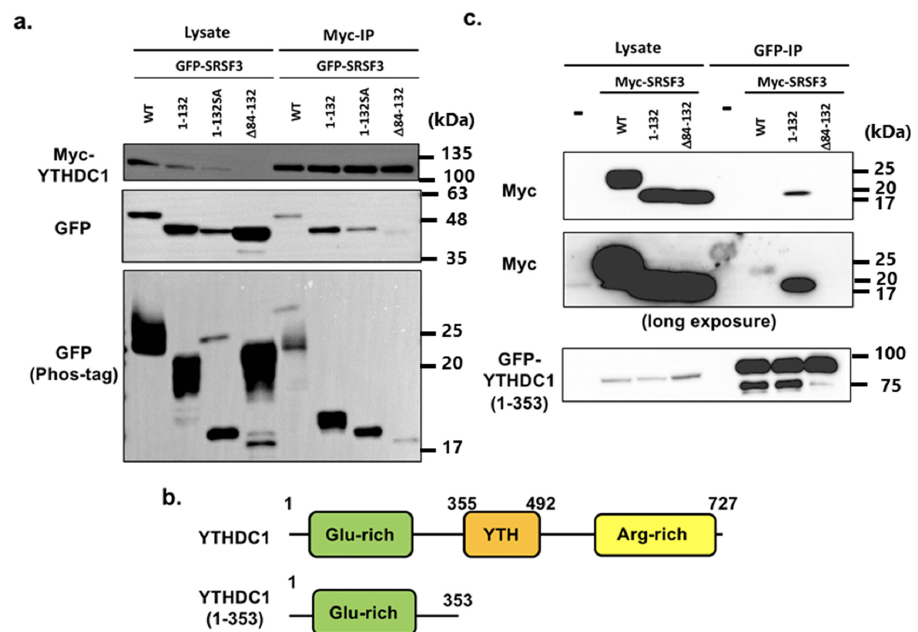
Figure 6. ( a ) HeLa cells were co-transfected with Myc-YTHDC1, GFP-SRSF3, or GFP-SRSF3 deletion mutants. The lysates of co-transfected cells were immunoprecipitated using anti-Myc antibodies. Lysates and IP samples were detected by western blotting using anti-GFP or anti-Myc antibodies. Phosphorylation status of immunoprecipitated SRSF3 and mutants was analyzed by separation using phos-tag gel (bottom panel). ( b ) YTHDC1 and its 1–353 fragment structure. ( c ) HeLa cells were co-transfected with GFP-YTHDC1(1–353), Myc-SRSF3, or Myc-SRSF3 deletion mutants. Lysates of co-transfected cells were immunoprecipitated using anti-GFP antibody. Lysates and IP samples were detected using anti-GFP or anti-Myc antibodies. YTHDC1(1–353) shows a clear interaction with SRSF3(1–132).